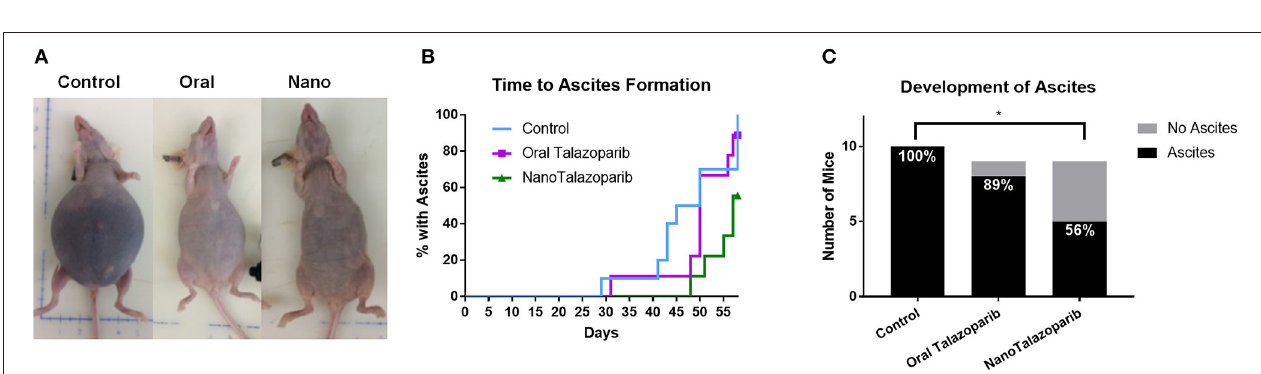
FIGURE 4 | (A) The accumulation of tumor ascites and abdominal distension are shown in representative images from each cohort at the time of sacrifice. (B) Mice were carefully monitored and the day in which each animal presented with ascites was recorded ( n = 10 in control group and n = 9 in treated groups). (C) Number of mice with ascites at the endpoint. Statistical significance was determined using Chi-square for proportions, * p < 0.05 vs.